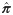
Scatter plot of observed heterozygozity (HO) against average inbreeding coefficients (fROH, fis) and familial relationships (π^) per herd and island.